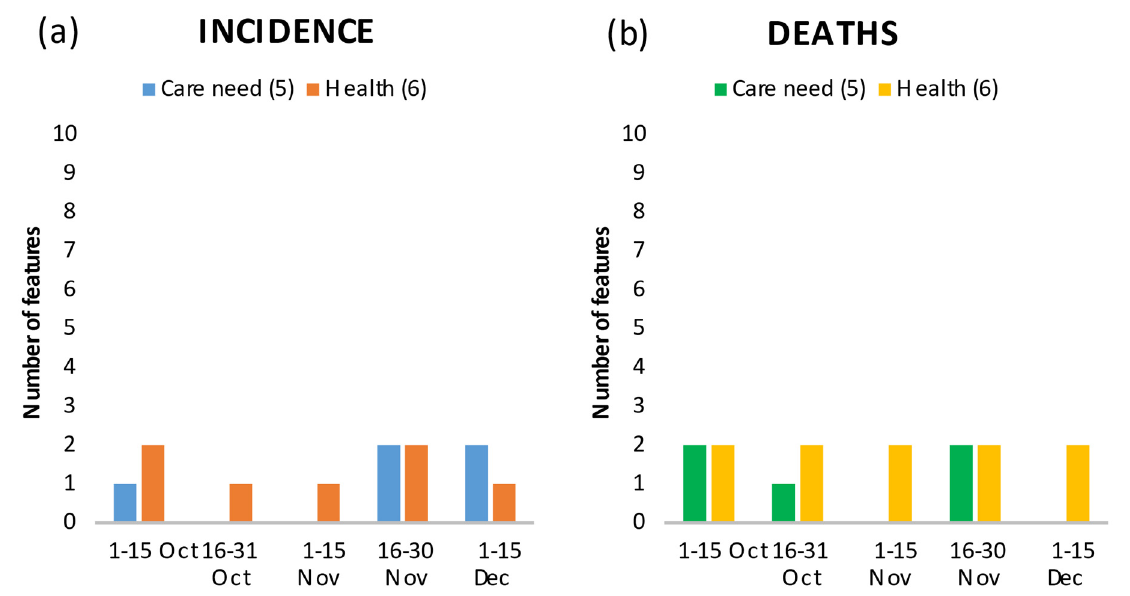
Figure 4. Number of features in the top 20 showing the relationship between urbanity/rurality and density, and incidence ( a ) and death rates ( b ) by time period.